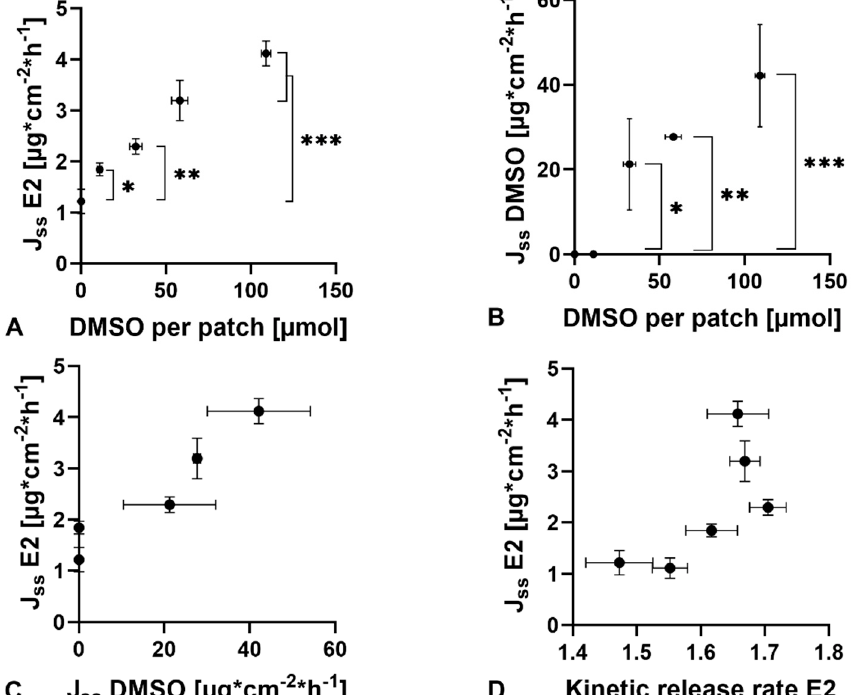
Figure 5. ( A ) Correlation between steady-state flux (J ss E2) of estradiol and DMSO per patch (R 2 = 0.972). ( B ) Correlation between steady-state flux of DMSO (J ss DMSO) and DMSO per patch (R 2 = 0.924). ( C ) Correlation between steady-state flux of estradiol (J ss E2) and steady-state flux of DMSO (Jss DMSO) (R 2 = 0.884). ( D ) Correlation between kinetic release rate of estradiol (J ss E2) and steady-state flux of estradiol (J ss E2) (R 2 ≤ 0.5). * Indicates significant differences ( p < 0.05), ** indicates significant differences ( p < 0.01) and *** indicates significant differences ( p < 0.001).